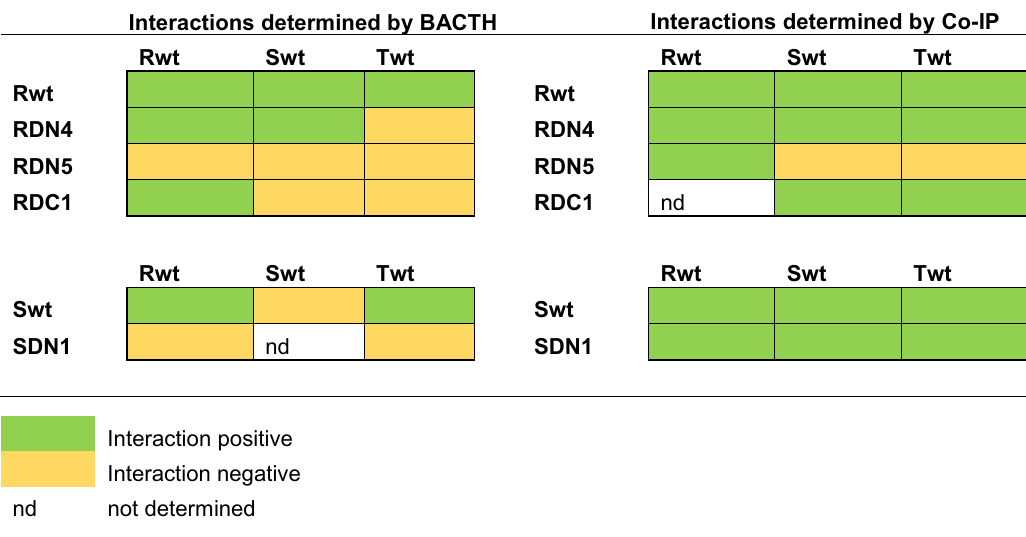
Table 1. Summary of results from BACTH and Co-Immuno-precipitation (Co-IP)